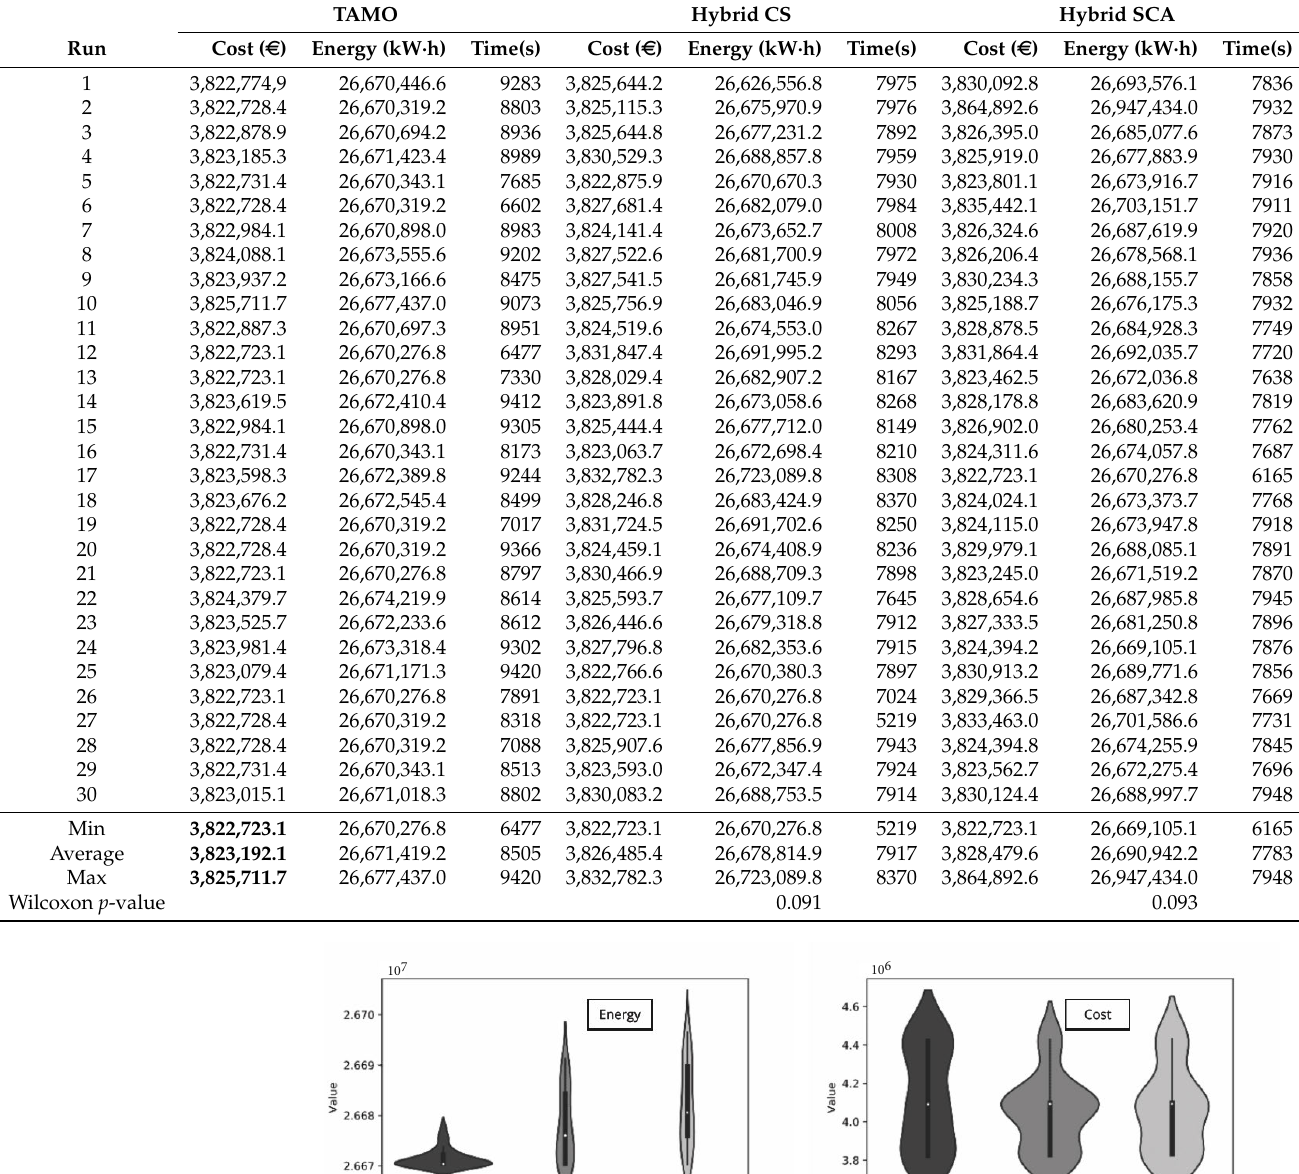
Table 9. Cost minimization results for 30 executions of TAMO, hybrid CS and hybrid SCA algorithms.